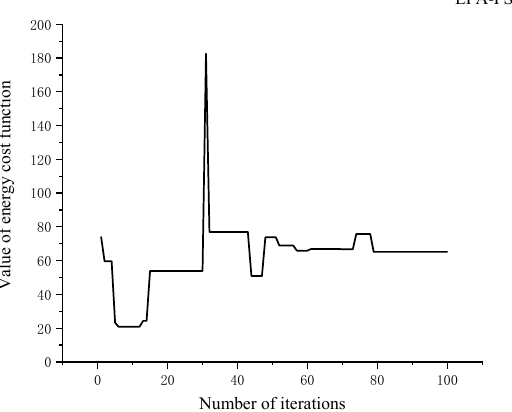
Figure 31. Fitness of EPA-PSO algorithm after 100 iterations.